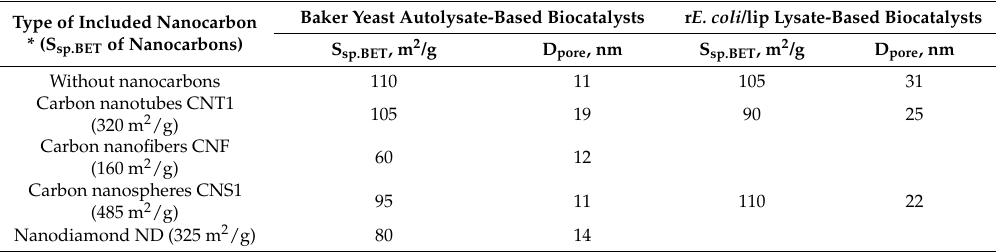
Table 3. Textural characteristic of composite lysate-based biocatalysts depending on the type of included nanocarbons and enzymatic activity of prepared